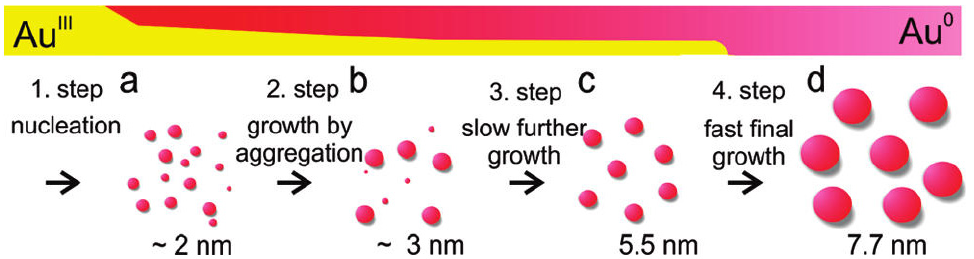
Figure 12. Mechanism of gold nanoparticles formation